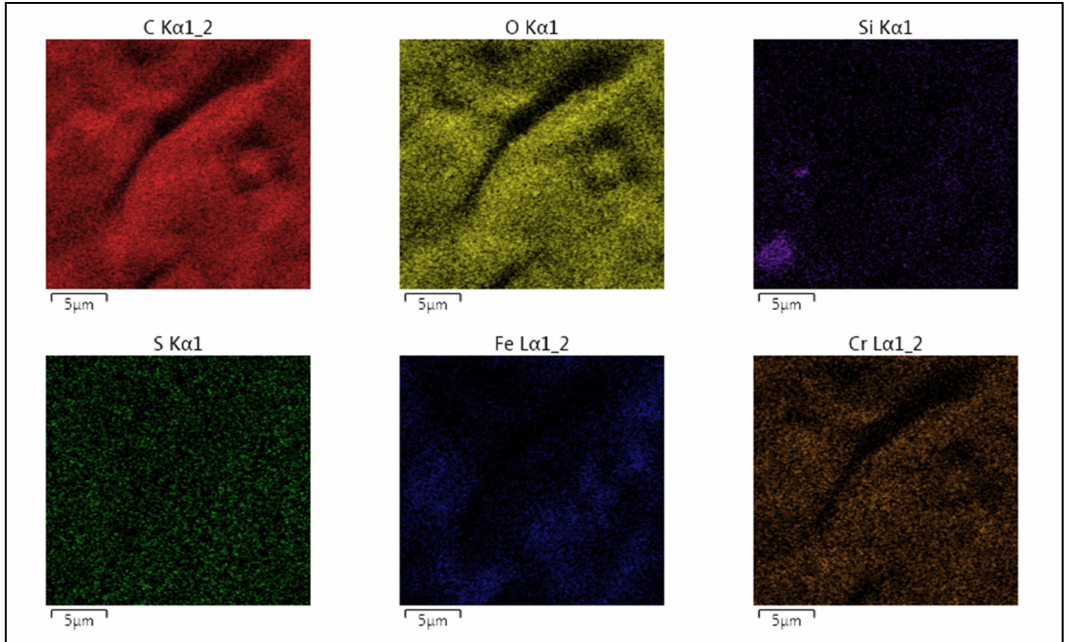
Figure 16. Distribution of C, O, Si, S, Fe and Cr elements obtained by mapping of the GO samples on stainless steel